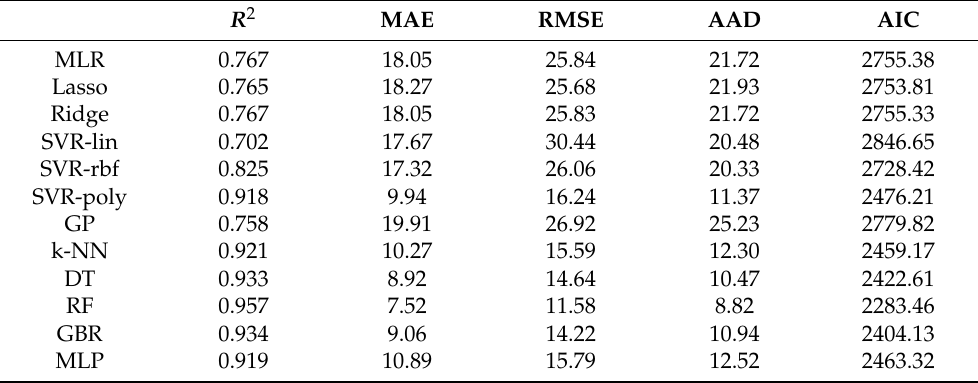
Table 6. Calculated metrics for all ML algorithms applied to the dataset for all eight inputs. R